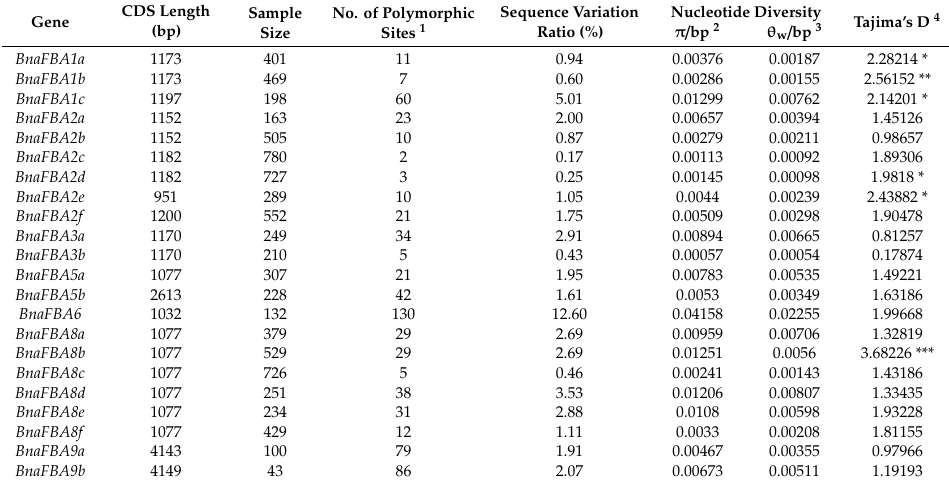
Table 3. Summary of Polymorphic Sites of the 22 BnaFBA